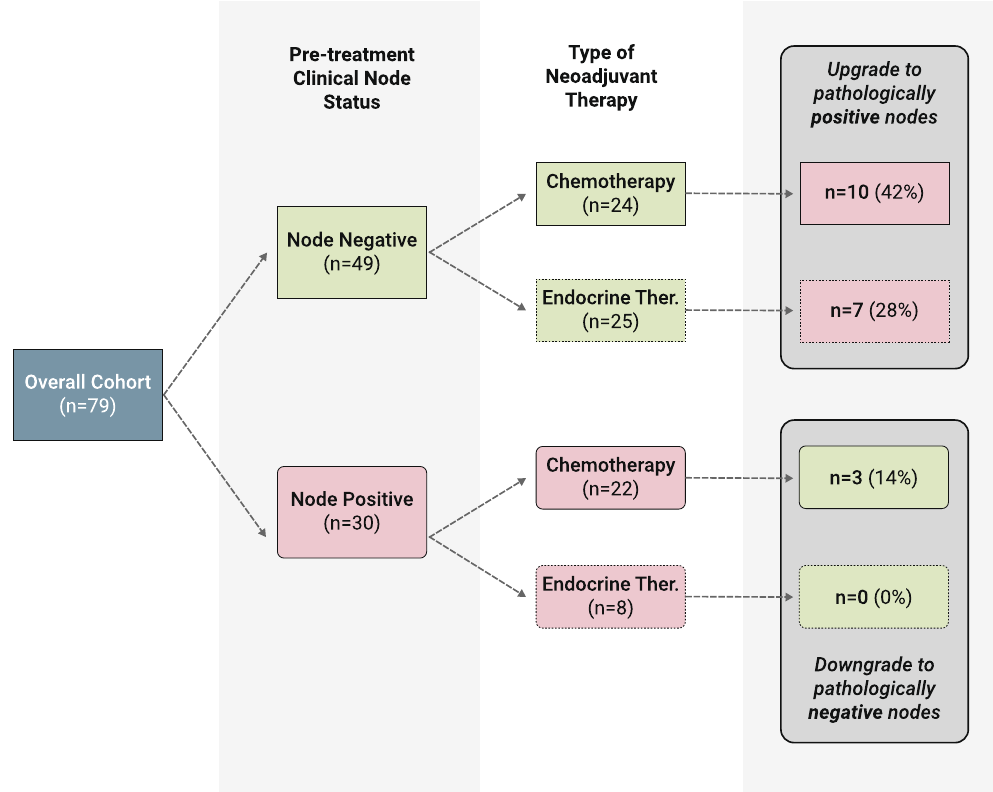
Fig. 3 Upgrade and downgrade rates following neoadjuvant therapy by clinical node status. Pathologic node status following neoadjuvant chemotherapy or endocrine therapy in clinically node negative and positive